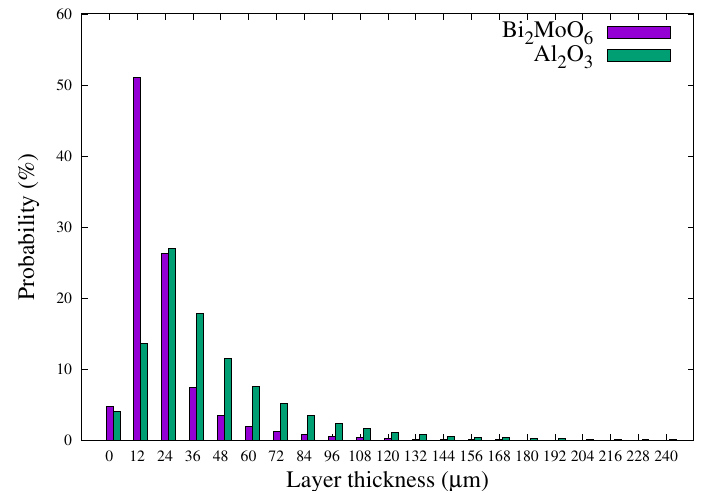
Figure 9. Range of thickness values in the cases of Al